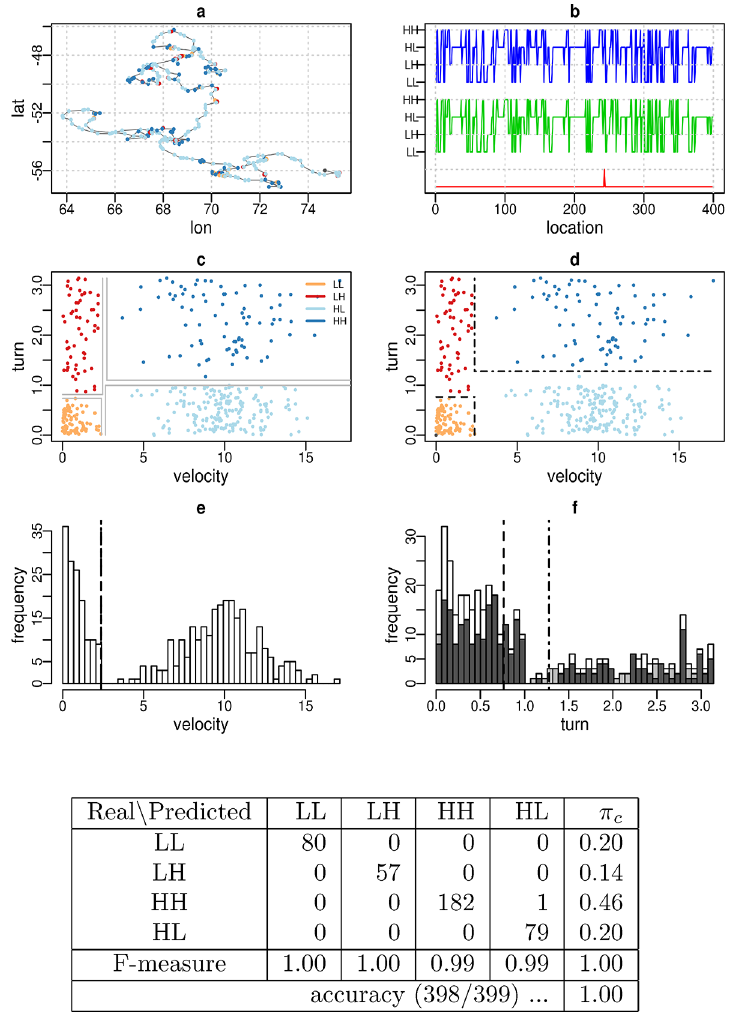
Fig 6. Synthetic trajectory. Simulated trajectory with N = 400 and γ = 0.05. Panels: (a) trajectory grid plot, (b) temporal behaviour profile with output labelling (top), reference labelling (centre) and labelling differences between them (bottom), (c) reference velocity/turn scatter plot showing the limits of the binary regions (grey lines), (d) output velocity/turn scatter-plot showing the resulting delimiters r . L , r L . (dashed lines) and r . H , r H . (dot-dashed lines), (e) velocity, and (f) turning angle frequency distributions (white colour). The turn distribution for low/high values of velocity is shown separately in light/dark grey colours, respectively. Bottom: Confusion matrix and performance